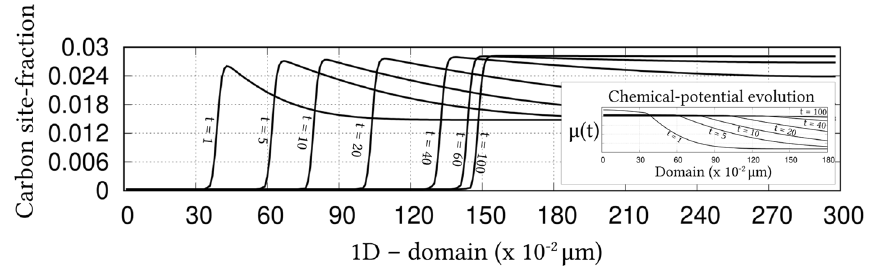
Figure 6. Evolution of carbon concentration, in site-fraction, accompanying the decomposition of austenite. The temporal change in the dynamic variable, i . e chemical potential of carbon, is included as a subplot.